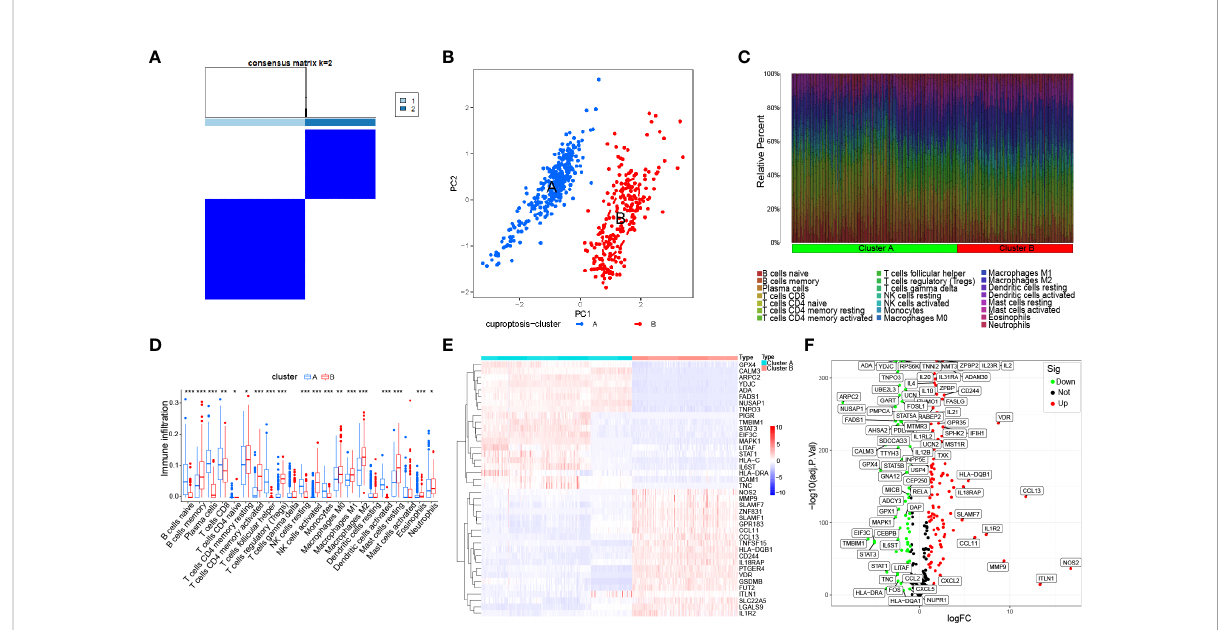
FIGURE 4 Identi fi cation of the molecular subtypes in IBD based on the expression of immune-related cuproptosis genes. (A) Consensus matrix (k=2) de fi ning two clusters and their correlation area among 540 IBD samples. (B) PCA analysis between cuproptosis cluster A and cluster (B, C) . Bar plot visualizing in fi ltration of 22 immune cells between the two clusters. (D) Violin plot of differentially in fi ltrated immune cells between the two clusters. Asterisks indicate signi fi cances: *p ≤ 0.05, **p ≤ 0.01, ***p ≤ 0.001. (E) Heatmap showing differential expression of the top 50 genes among 162 IBD risk genes between the two clusters. (F) Volcano plot representing all differential IBD risk genes with logFC>1 and P-value <0.05 between the two